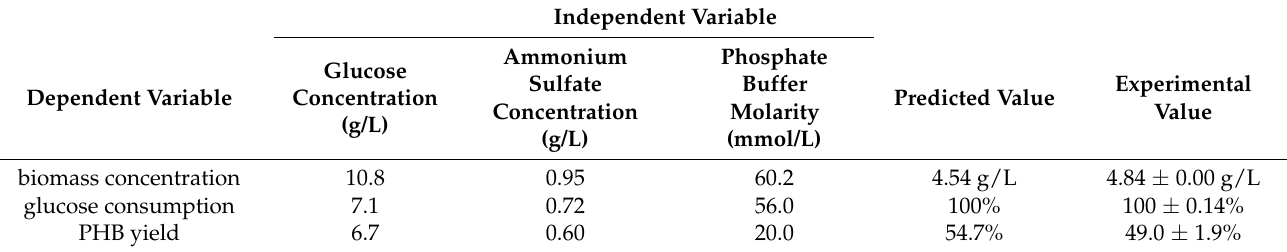
Table 4. Predicted and experimentally measured values for dependent variables under optimal propagation media